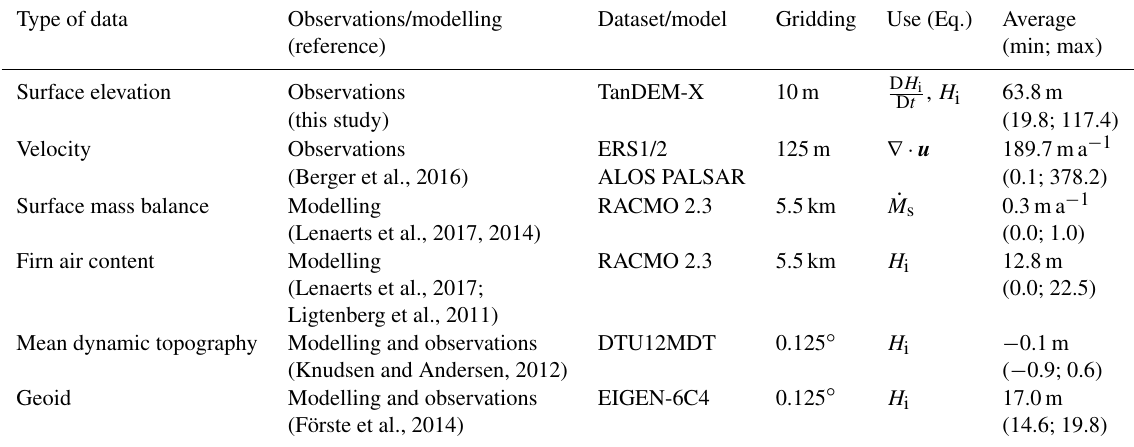
Table 1. Key features of the main input datasets used to compute the variables of Eq. (1c). Type of